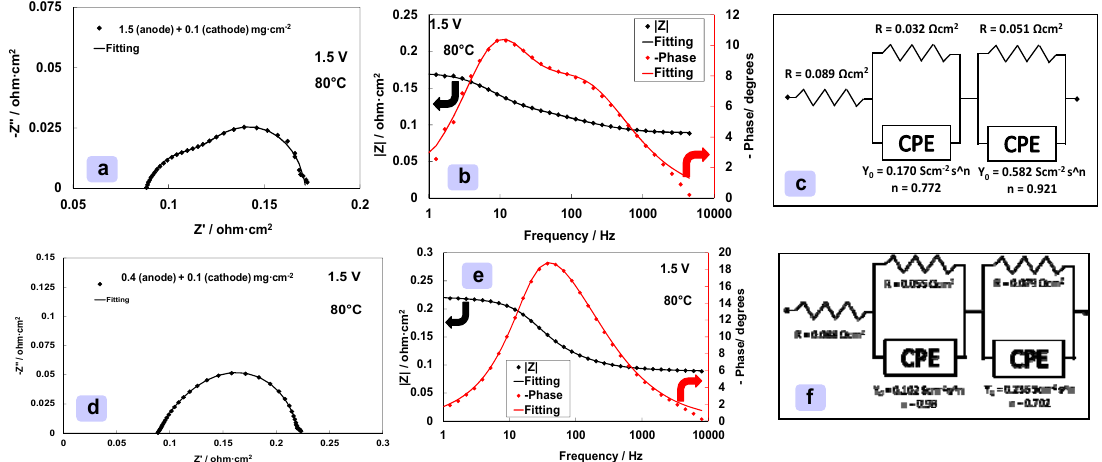
Figure 8. EIS at 1.5 V and 80 °C for high ( a – c ), 1.5 mg cm − 2 , and medium ( d – f ), 0.4 mg cm − 2 , anode catalyst loading MEAs.